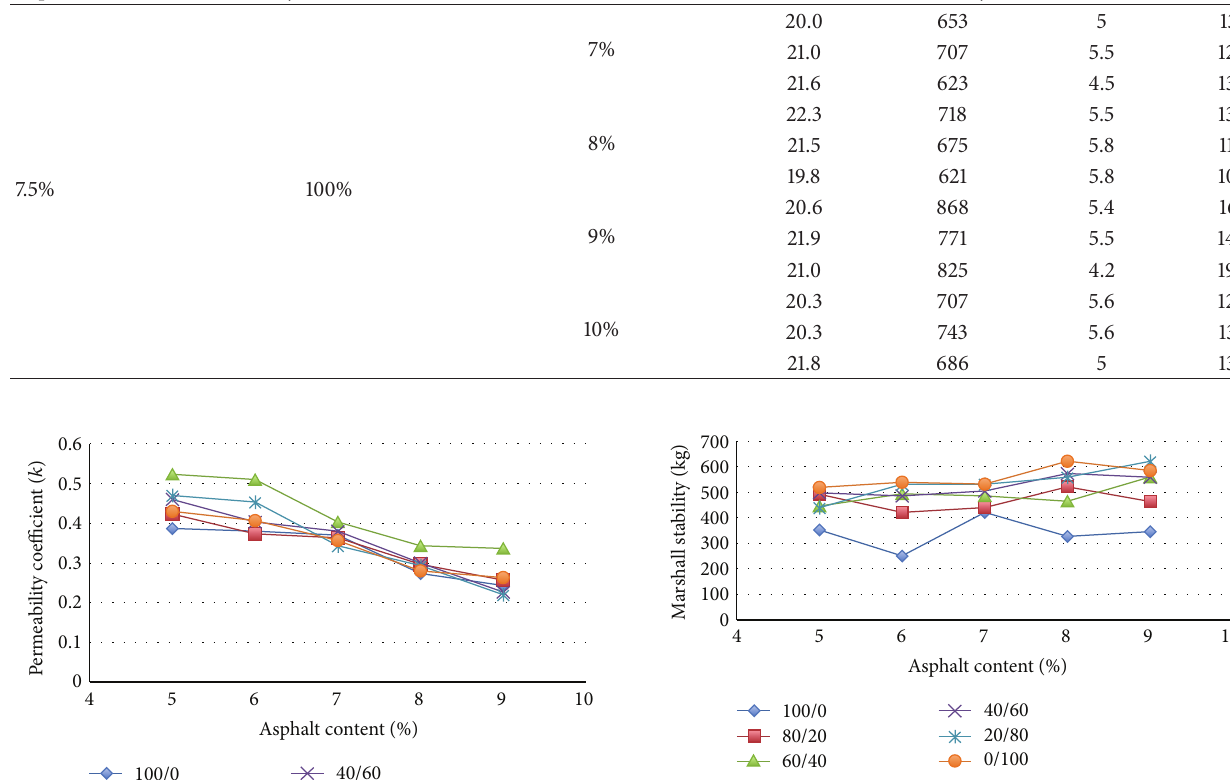
Figure 4: Marshall stability of specimens (kg) at each asphalt content and coarse aggregate